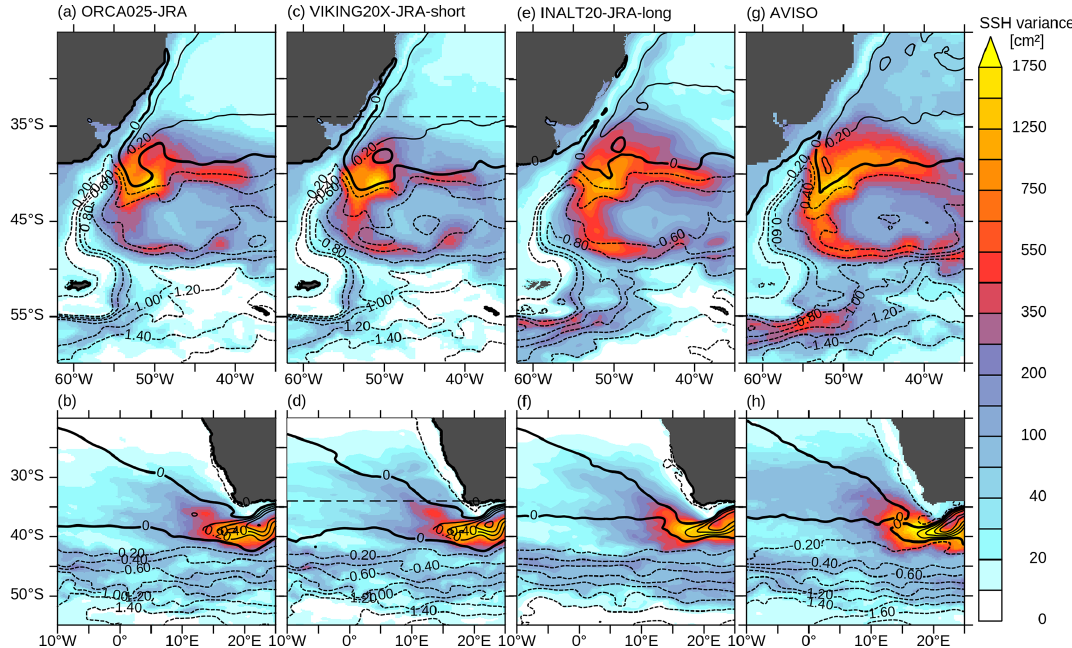
Figure 18. Sea surface height in the Brazil–Malvinas confluence zone (upper row) and west Agulhas region (lower): 1990–2009 mean (contours, in m) and variance (shaded, in cm 2 ) in (a, b) ORCA025-JRA, (c, d) VIKING20X-JRA-short, (e, f) INALT20-JRA-long and (g, h) from satellite altimetry. Dashed lines in (c) and (d) mark the southern boundary of the nested region in VIKING20X.